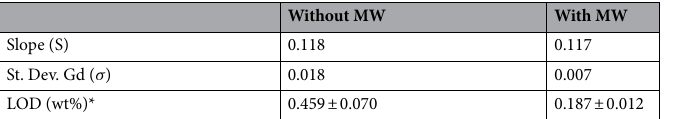
Table 1. Limit of detection (LOD) of Gd in surrogate nuclear debris using MWE-FC-MLIBS with ceramic micro-laser and helical coil antenna. Without the microwaves, the LOD is also shown. *Limit of detection (LOD) = 3 σ / S . σ : standard deviation of Gd/Ce at 0% Gd. S : calibration slope.